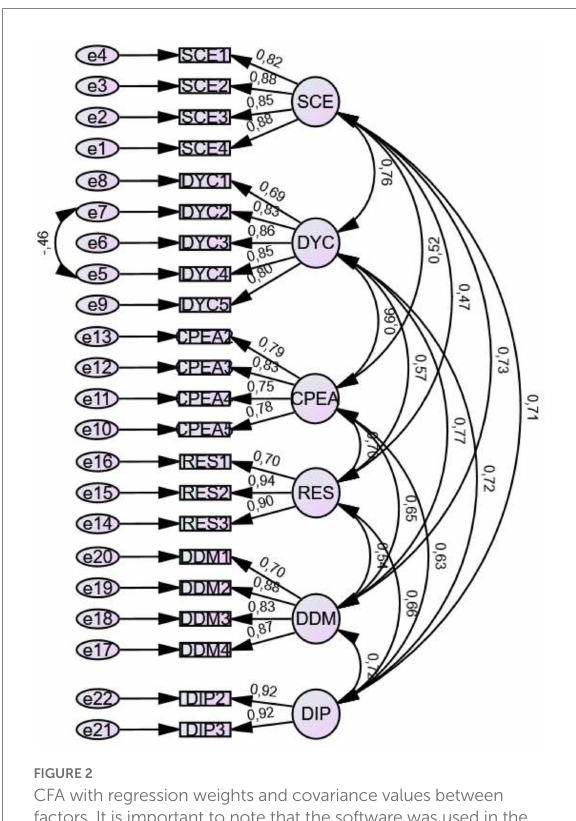
FIGURE 2 CFA with regression weights and covariance values between factors. It is important to note that the software was used in the Spanish language, so the comma “represents the decimal